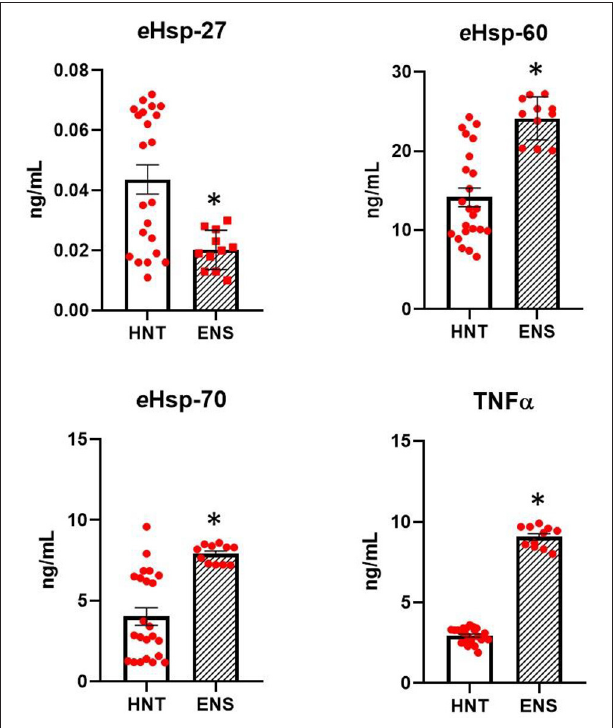
FIGURE 2 | Comparison in the secretion of e Hsp-27, e Hsp-60, e Hsp-70, and TNF α between healthy neonates at term (HNT, n = 23) and neonates with early-onset neonatal sepsis (ENS, n = 11). Concentration was expressed as ng/ml. Data represent the mean ± SEM. Statistical difference was observed between both groups * p ≤